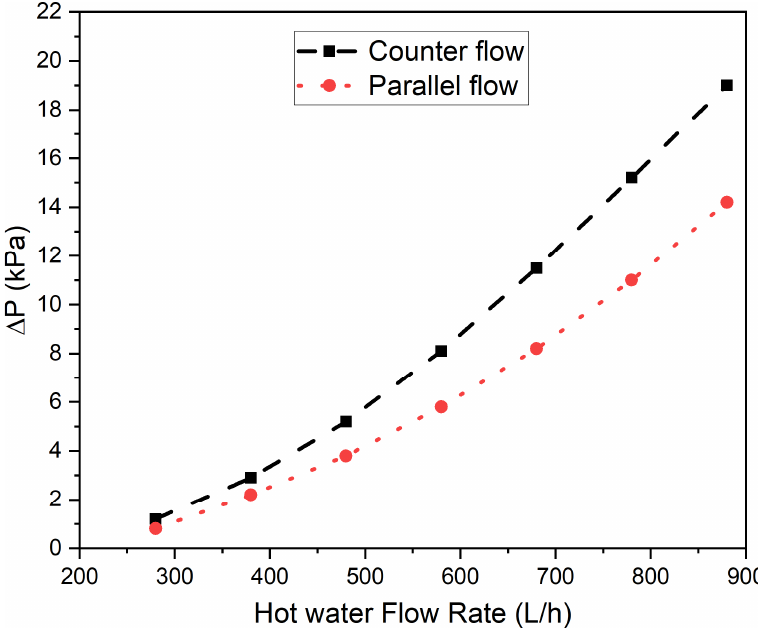
Figure 5. The relationship between pressure losses ( ∆𝑃 ) and counter and parallel hot water flow rates at the original case.